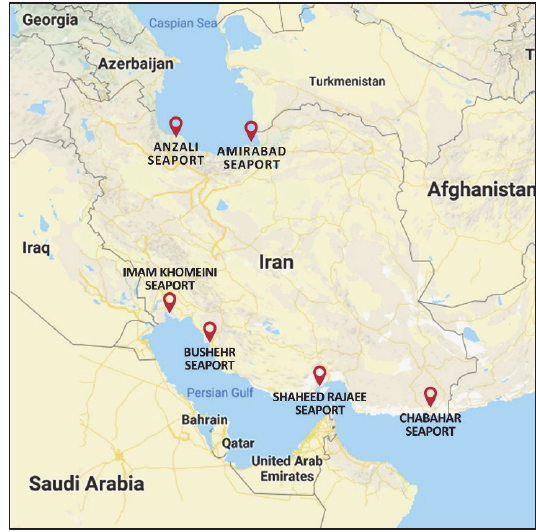
Fig. 2. Location of Iran's seaports that have the necessary equipment for importing